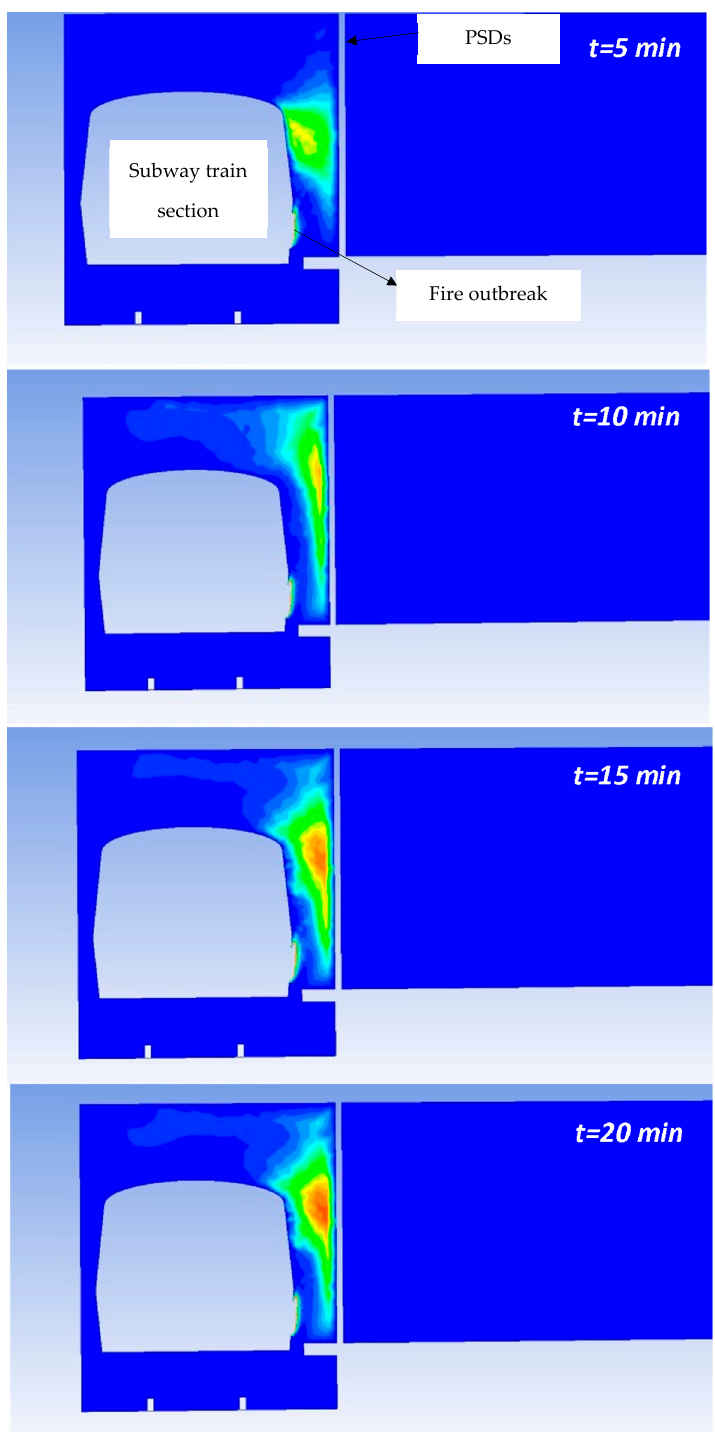
Figure 13. Temperature contours (°C)—cross section through the fire outbreak (minutes 5–20).